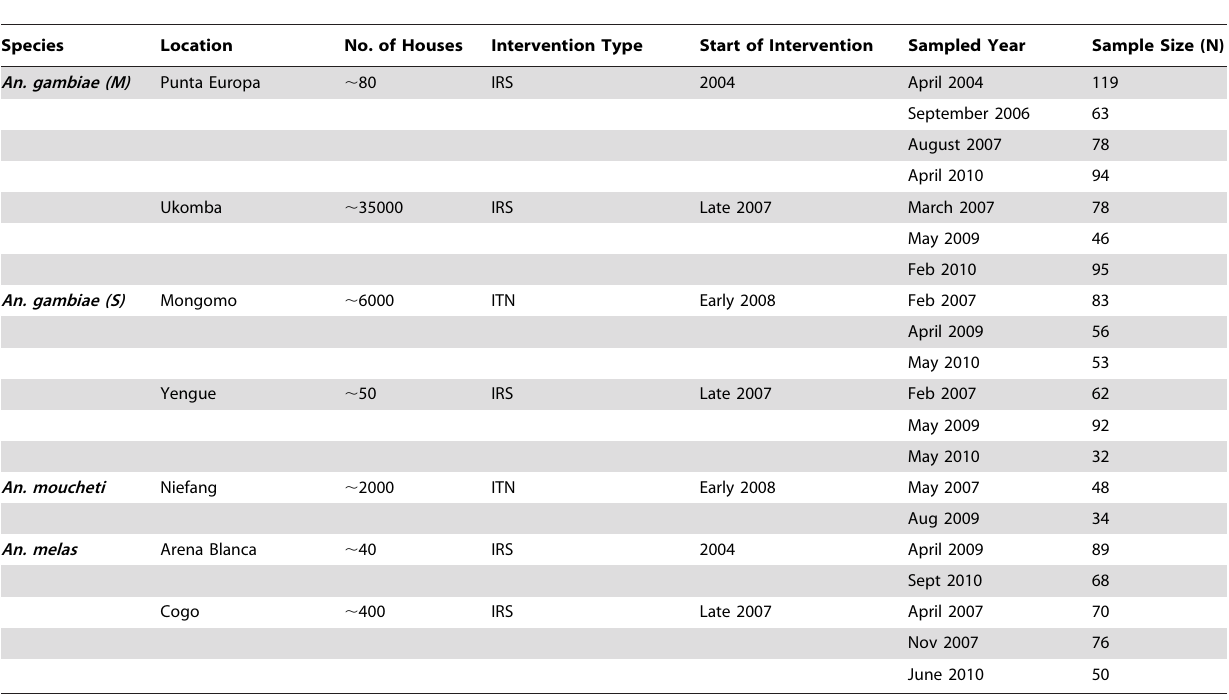
Table 1. Study species, sites, sampling years, and sample sizes that were the basis for estimations of N e and comparisons of alternate demographic scenarios in ABC